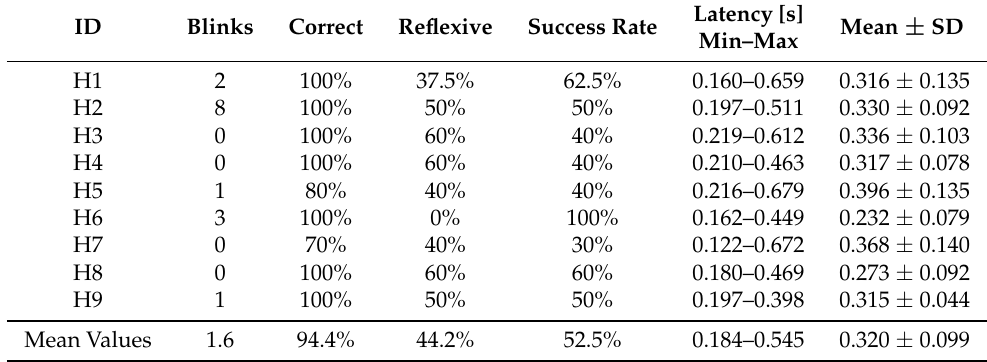
Table 7. Antisaccadic test: main features for the healthy control group.